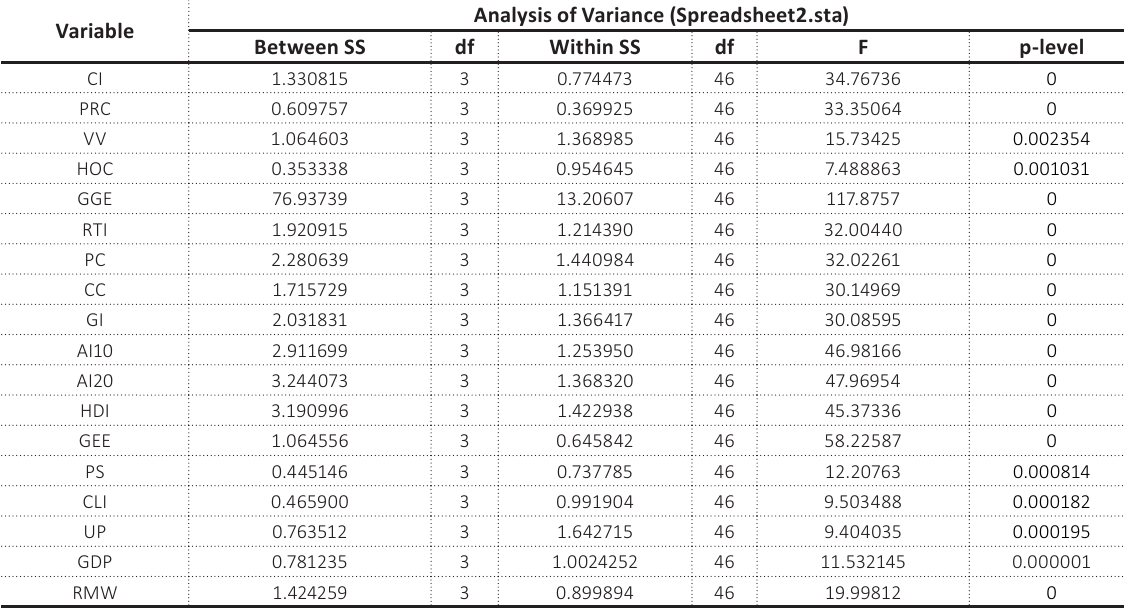
Analysis of Variance